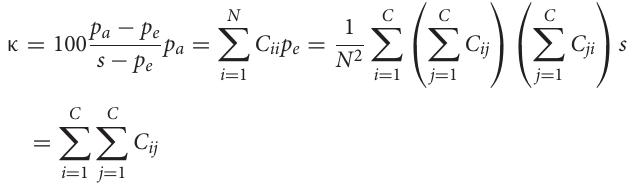
Predicted class Sick Healthy